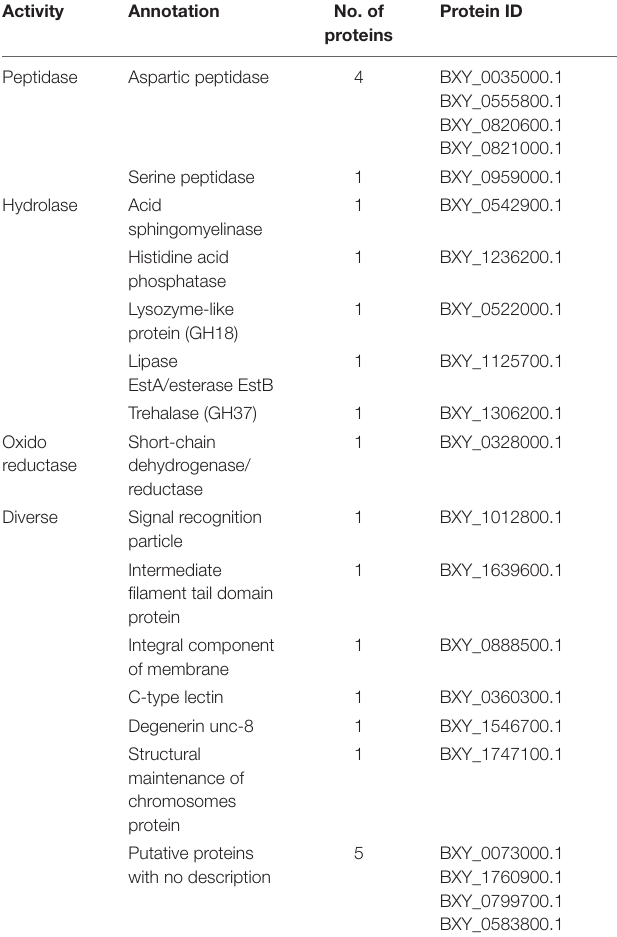
TABLE 1 | Description of increased proteins in Bursaphelenchus xylophilus secretome under the Pinus pinaster stimulus, based on molecular function gene ontology